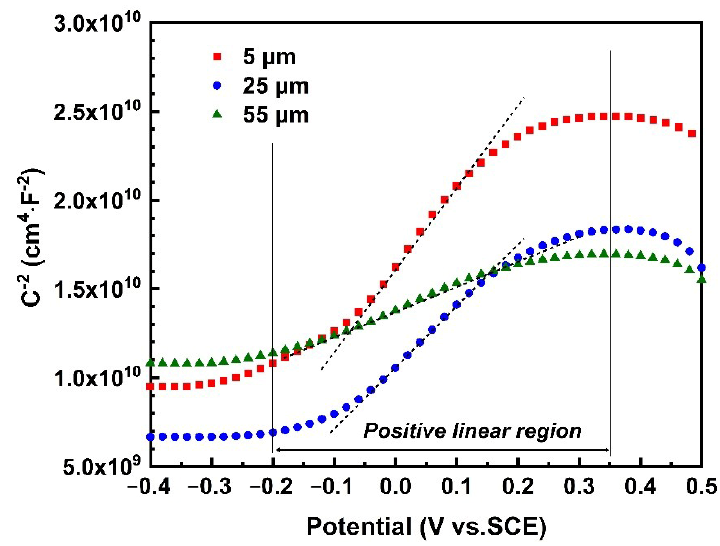
Figure 7. Mott–Schottky plots of 316L SS after 2 h CE with different amplitudes.